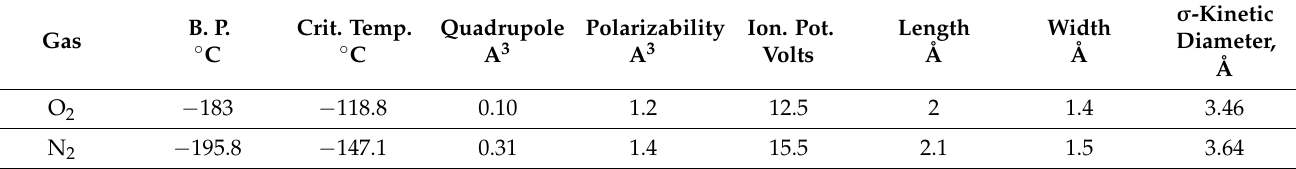
Table 1. Physical constant of adsorbate gases [23].